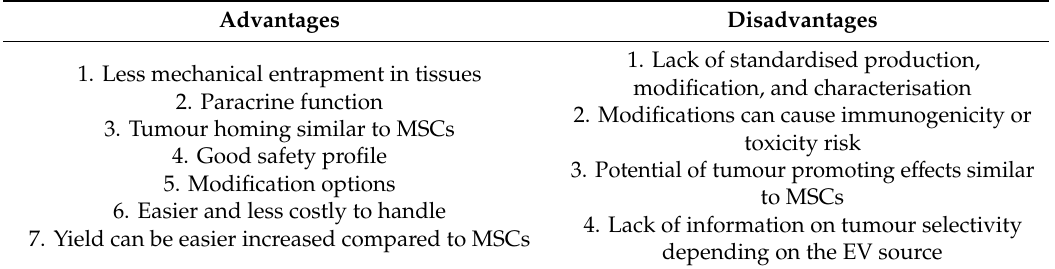
Table 3. Advantages and disadvantages of MSC-EVs over